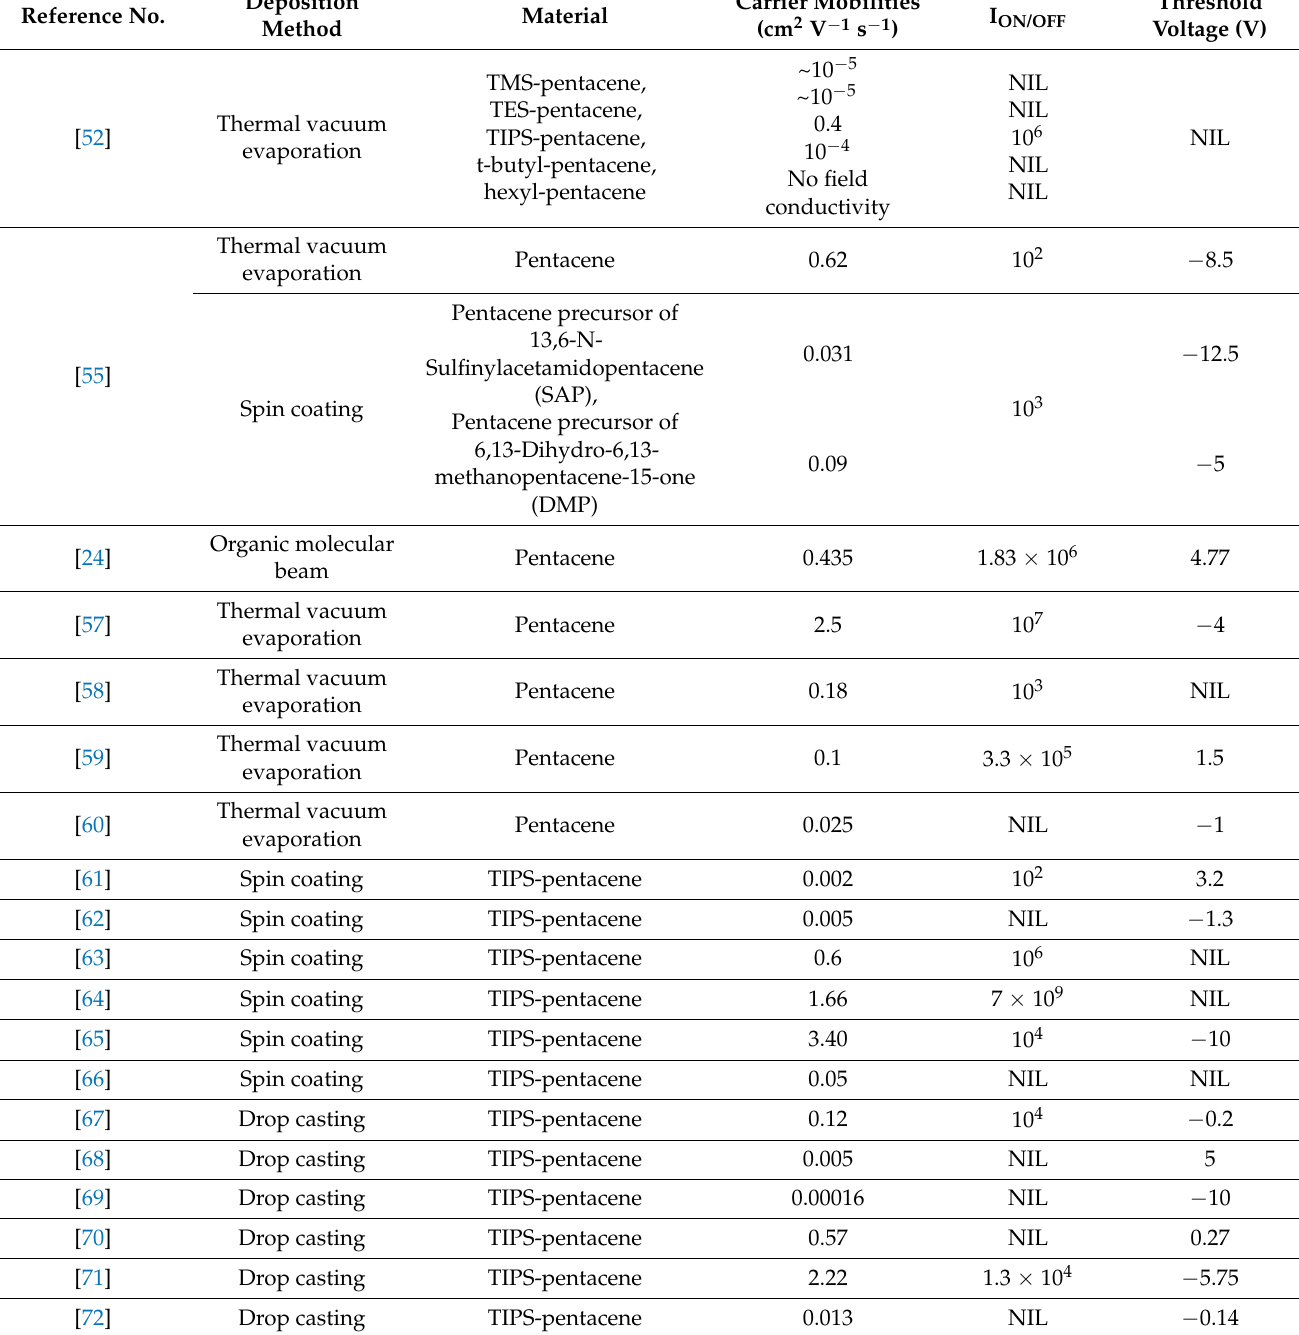
Table 1. Electrical performance comparison of OTFTs based on pentacene and its derivatives. Reference